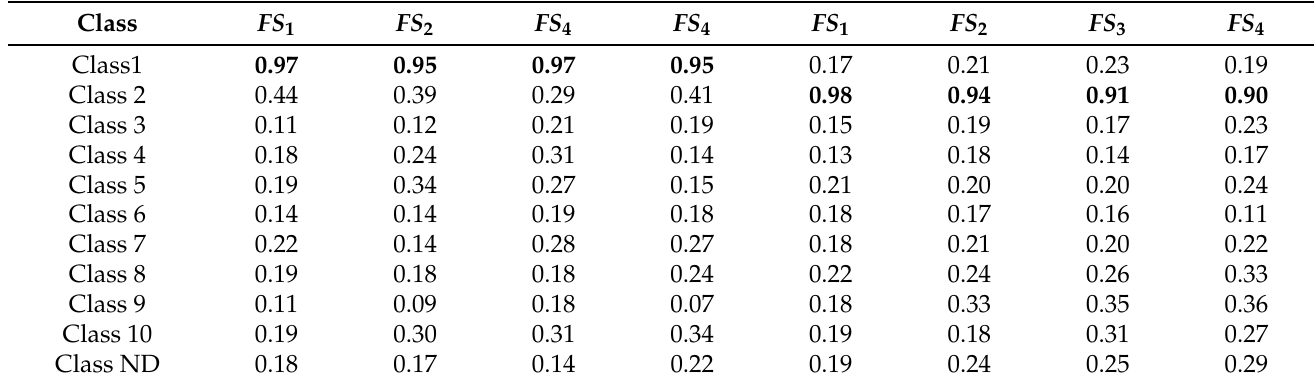
Table 5. FS 1 , FS 2 , FS 3 and FS 4 values obtained by comparing the EC map of classes 1 and 2 with the remaining classes (the values highlighted in bold refer to the best performances).